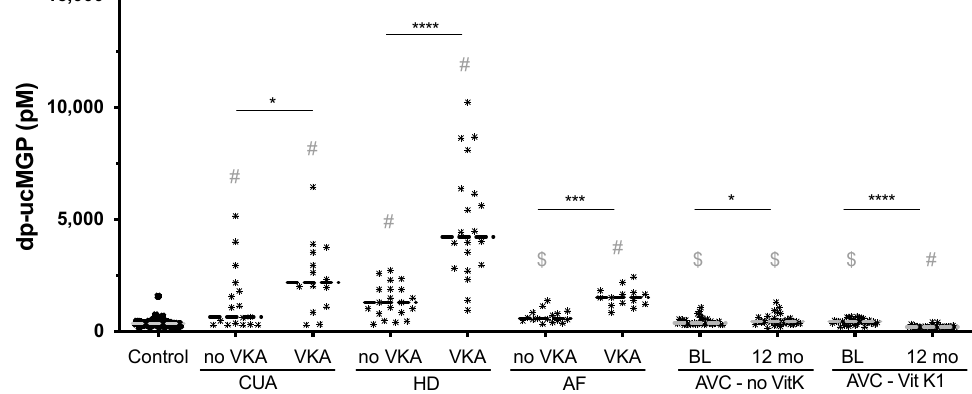
Figure 1. dp-ucMGP measurements of all disease cohorts and a control group. VKA use exacerbated dp-ucMGP status in all cohorts, while vitamin K supplementation ameliorated the dp-ucMGP status beyond healthy controls. Compared to controls, all HD and CUA groups had significantly increased dp-ucMGP levels, while in the AF cohort only the VKA group was increased. Dash indicates the median. Significance levels: * = p ≤ 0.05; *** = p ≤ 0.001; **** = p ≤ 0.0001. # and $ indicate the comparison between each disease group and the control group. # indicates a significance level of p ≤ 0.0001, and $ indicates no significant difference between the respective group and the control group.